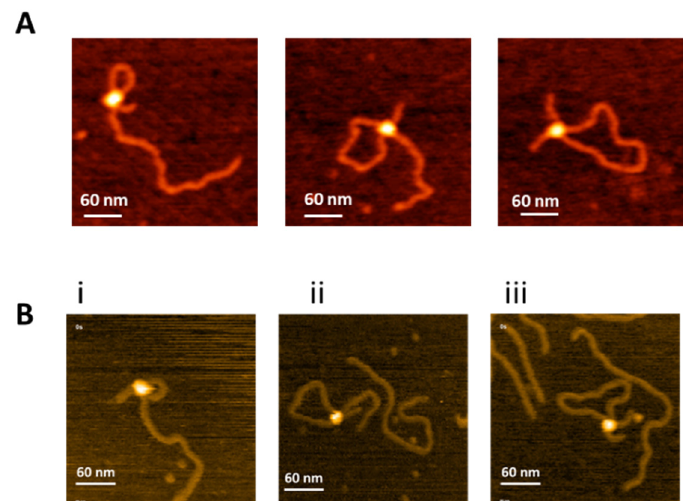
Figure 2. Specific SfiI-DNA synaptic complexes with different loop sizes. ( A ) Left to right, dry AFM images of SfiI-DNA synaptic complexes with small, medium, and long loops sizes of 254 bp, 532 bp, and 786 bp, respectively. ( B ) Initial frames of HS-AFM movies (Movie S2a–c) showing the SfiI-DNA synaptic complexes with small ( i ) medium ( ii ) and long ( iii ) loops.